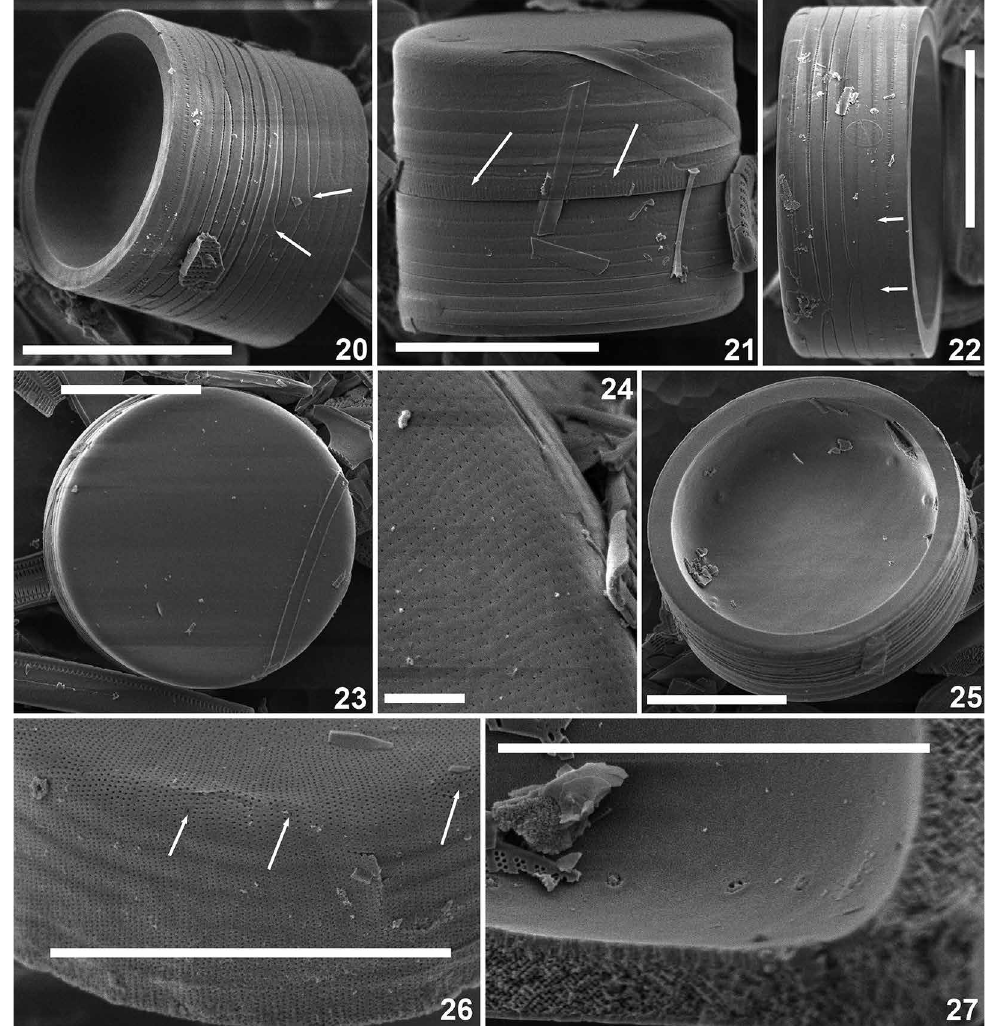
Figs 20–27. Angusticopula chilensis (Grunow) Houk et al . SEM. Campbell Island epitype population, sample BAS286. 20–22 . SEM view of several valves in girdle view showing the ligulate, open, narrow girdle bands. The arrows indicate the ligulae in Fig. 20, the rimmed mantle edge in Fig. 21 and the fimbriate pars interior of the copulae in Fig. 22. 23 . External view of a valve face. 24 . External detail of the very fine striae and the small, rounded areolae. 25 . Internal view of an entire valve showing the rimoportulae and the thick mantle. 26 . External view of the mantle/valve face junction with several openings of the rimoportulae (arrows). 27 . Internal detail of the valve mantle with some rimoportulae. Scale bars: 20–23, 25–26 = 10 μm; 24, 27 = 1